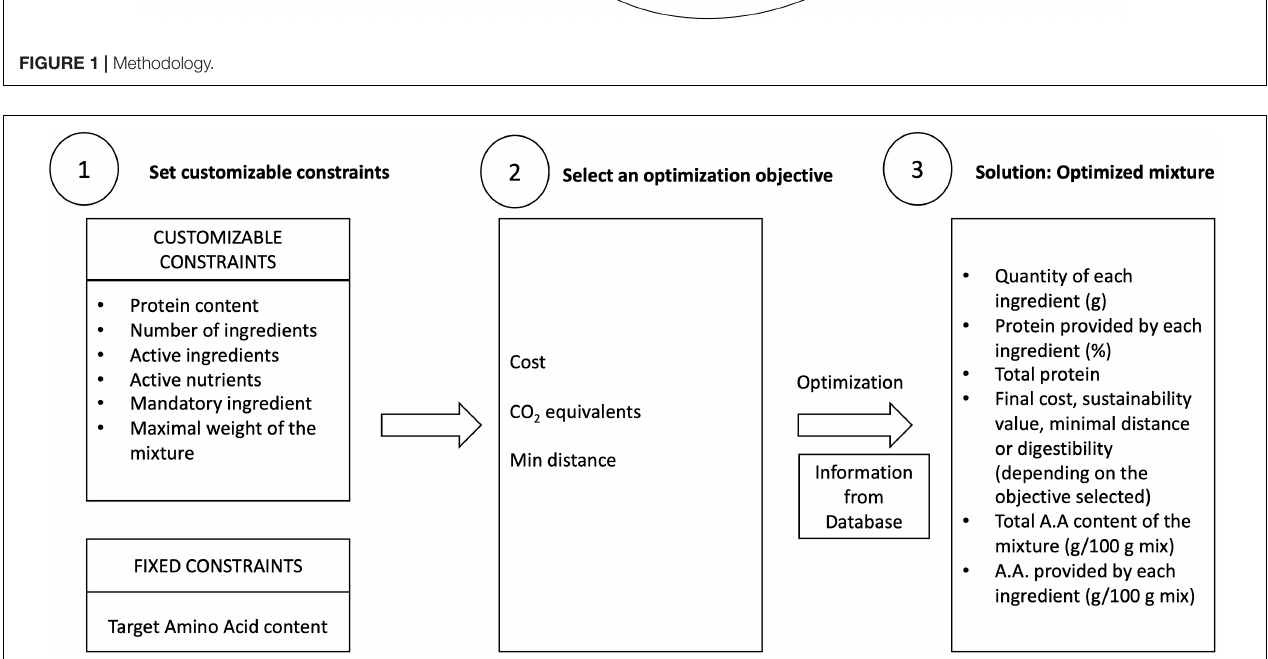
FIGURE 2 | Linear optimization